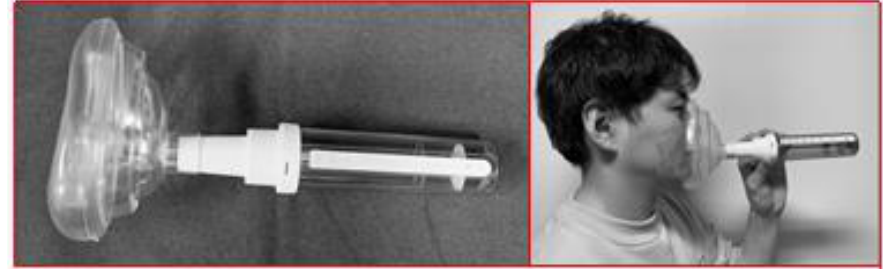
Figure 3. Photographs of the peak nasal inspiratory flow ( PNIF) meter and its use.